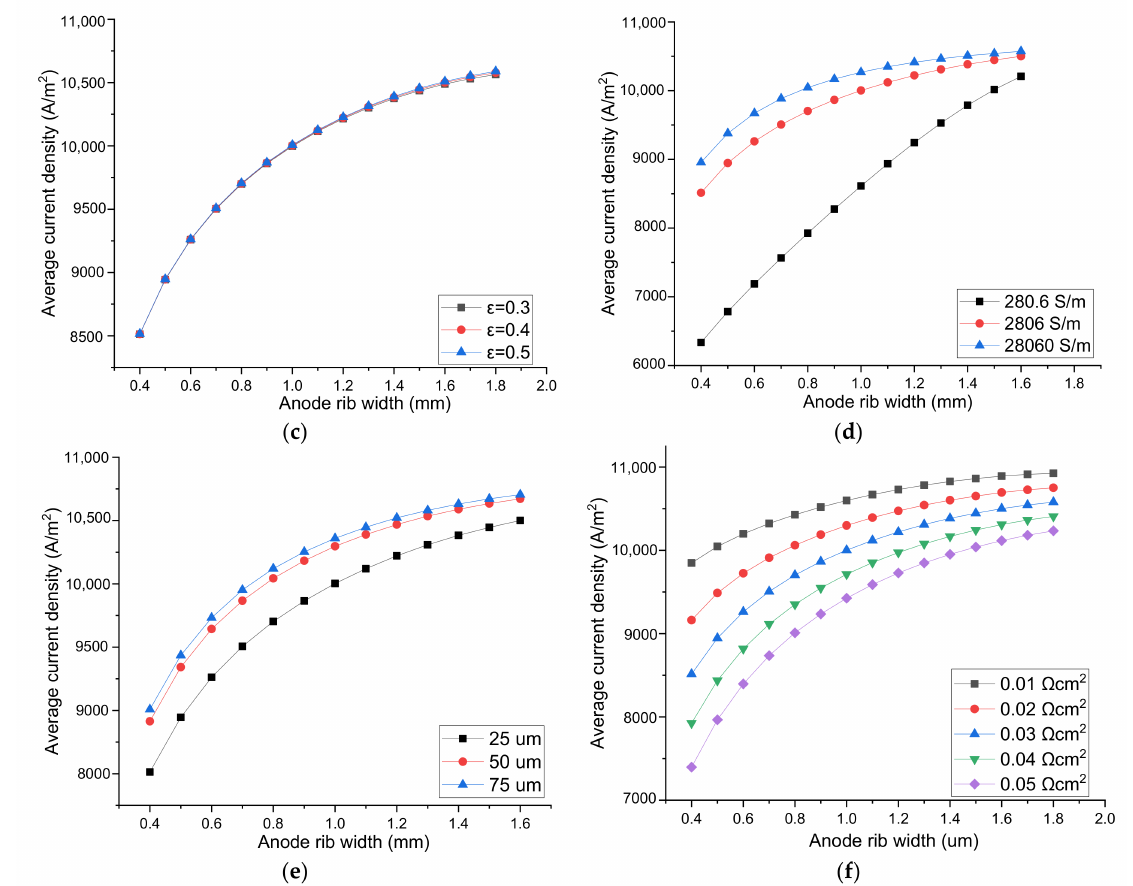
Figure 5. The e ff ect of parameters on SOEC performance and the optimal O 2 electrode rib width. H 2 electrode parameters: ( a ) rib / pitch ratio on the H 2 electrode side; ( b ) rib-H 2 electrode area specific resistance (ASR); O 2 electrode parameters: ( c ) porosity; ( d ) electrical conductivity; ( e ) thickness; ( f ) rib-O 2 electrode